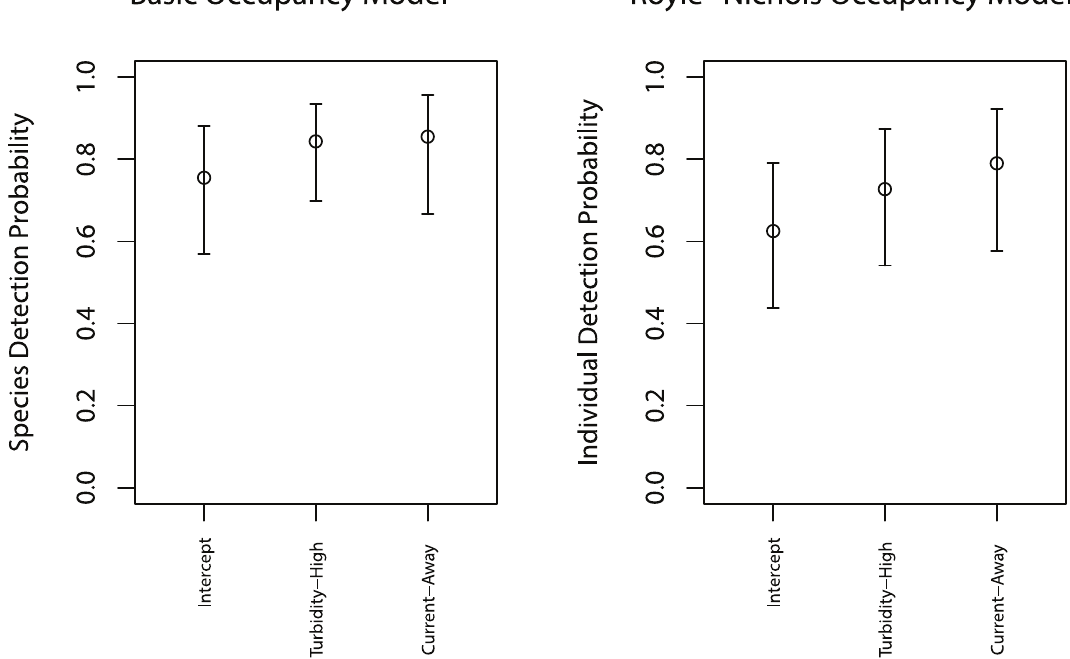
Figure 6. Camera trap detection probabilities as influenced by turbidity and current direction. The estimated detection probabilities at reference covariate values (intercept) and at high turbidity and with current direction away from the camera lens from both the basic occupancy model (left panel) and the Royle-Nichols model (right panel) for red snapper. Note that for the basic occupancy model framework the detection probability is for the species at occupied sites. In contrast, for the Royle-Nichols framework the detection probability is for each individual at occupied sites. The intervals represent 95% credible intervals.